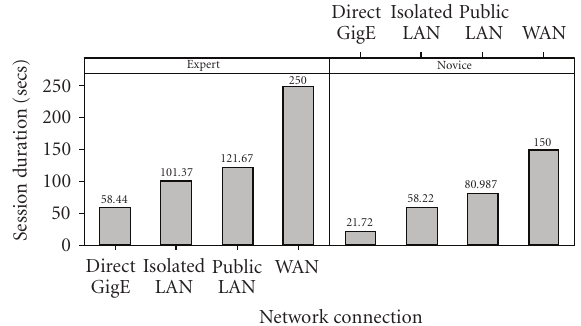
Figure 8: MOS ( q mos ) rankings comparison for varying ψ net condi- tions.